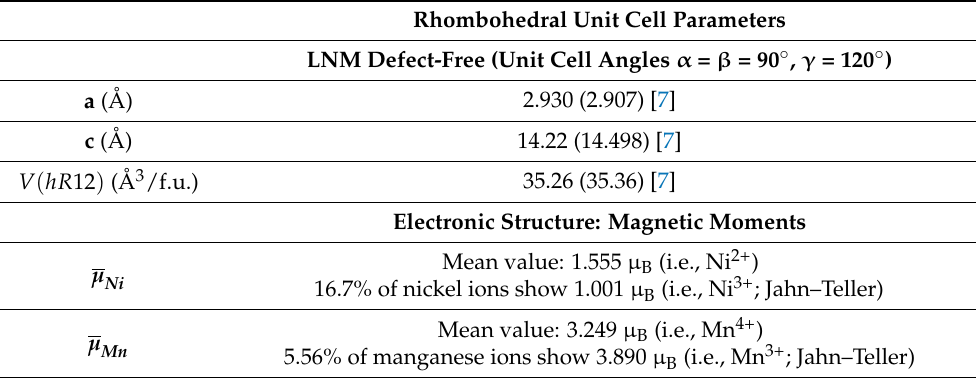
Table 1. Computed structural parameters and electronic structure analysis of the magnetic moments in the optimized defect ‐ free LNM phase: weighted means of μ(cid:3364) (cid:2898)(cid:2919) and μ(cid:3364) (cid:2897)(cid:2924) and values for Jahn– Teller centers. The experimental values are reported in parentheses.